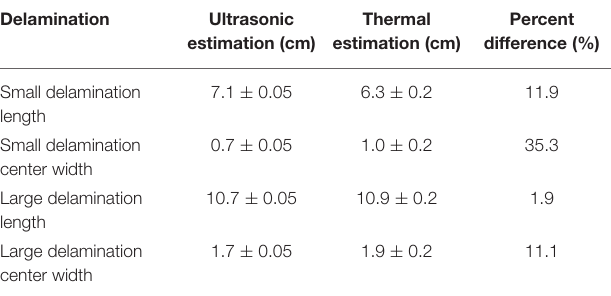
TABLE 1 | Comparison of thermal to ultrasound measurement of